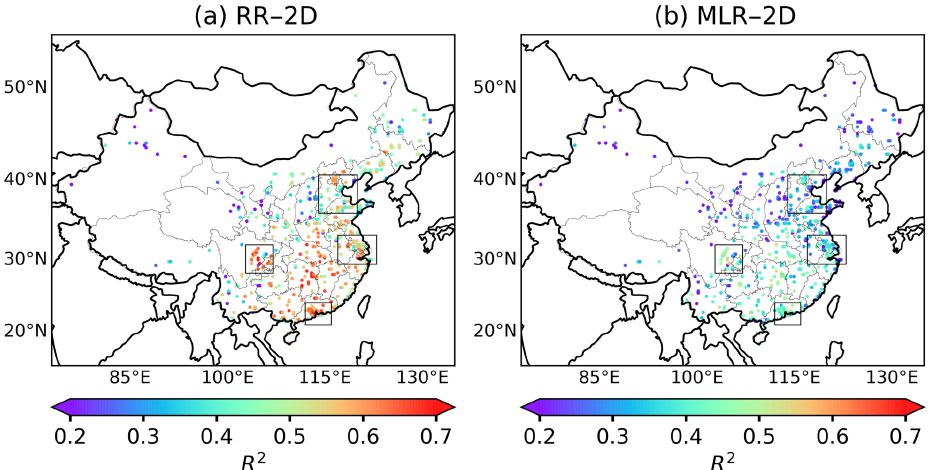
Figure 3. Coefficient of determination ( R 2 ) between deseasonalized observational MDA8 ozone and deseasonalized predicted values of MDA8 ozone in ridge regression (RR) with 2D expansion (a) and MLR with 2D expansion (b)